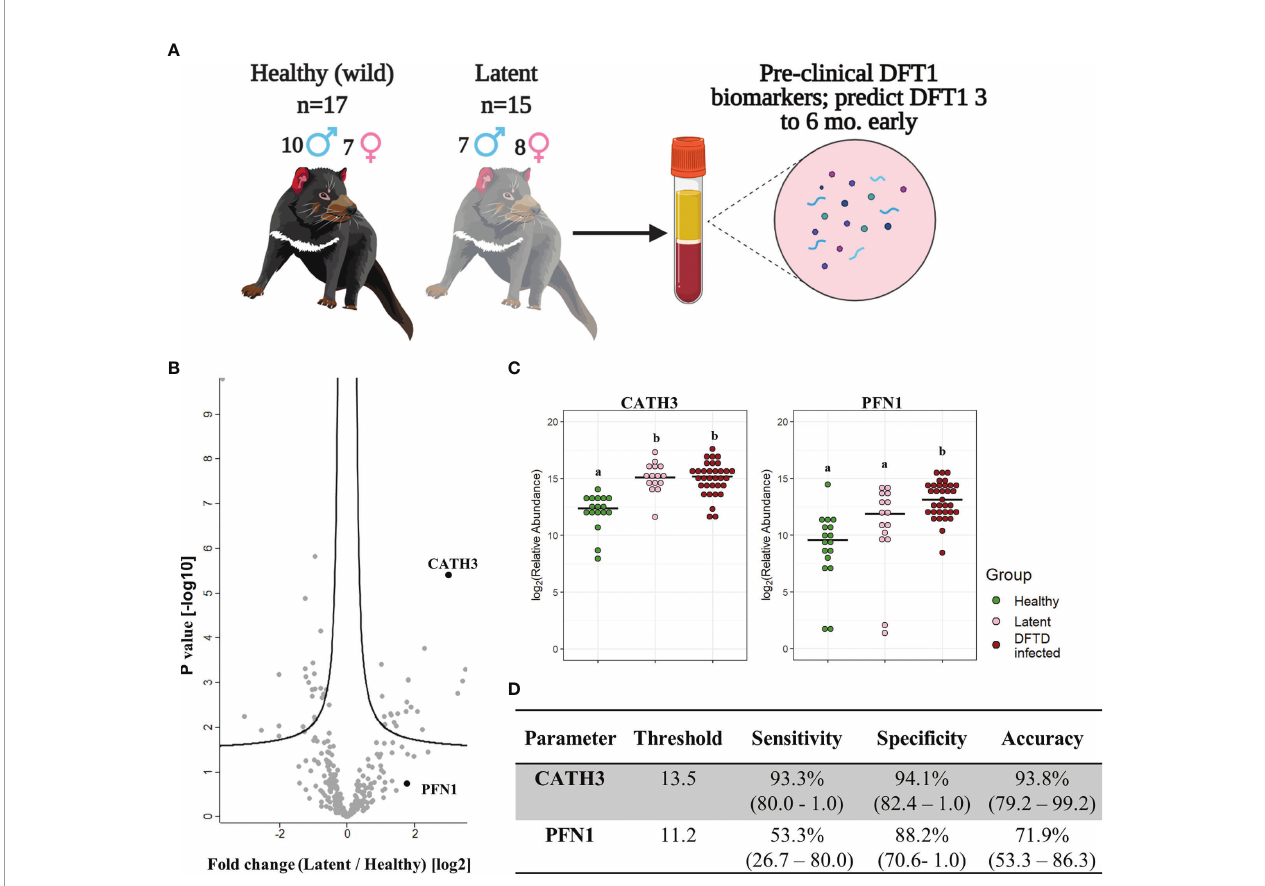
FIGURE 4 | CATH3 EVs detect DFTD in latent stages. (A) Isolated extracellular vesicles (EVs) from serum samples of 32 devils (15 DFTD latent and 17 healthy wild devils) were analyzed to investigate whether the validated DFTD biomarkers can also serve to predict latent stage DFTD 3 to 6 months before overt DFTD. (B) Volcano plot of protein relative abundance fold changes (log 2 ) between EVs derived from serum of DFTD latent devils (n=15) and healthy wild controls (n=17) vs fold change signi fi cance. (C) Dot plot showing the relative abundance of EV CATH3 and PFN1 detected in 17 wilds healthy, 15 latent, and 33 DFTD-infected devils, different letters “ a ” and “ b ” indicate signi fi cant pairwise differences between groups (i.e., groups denoted with the same letter are not signi fi cantly different; one-way ANOVA and Tukey post-hoc test, p < 0.05). (D) Receiver operating curve analysis performed to classify latent devils (n=15) from healthy controls (n=17). Sensitivity and speci fi city were calculated (95% con fi dence intervals) for latent devils based on the protein threshold trained with the full validation dataset